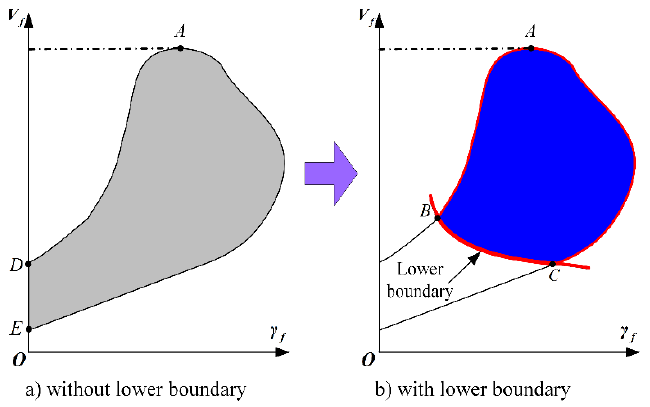
Figure 3. The boundary of aerocapture attainability set in state space.